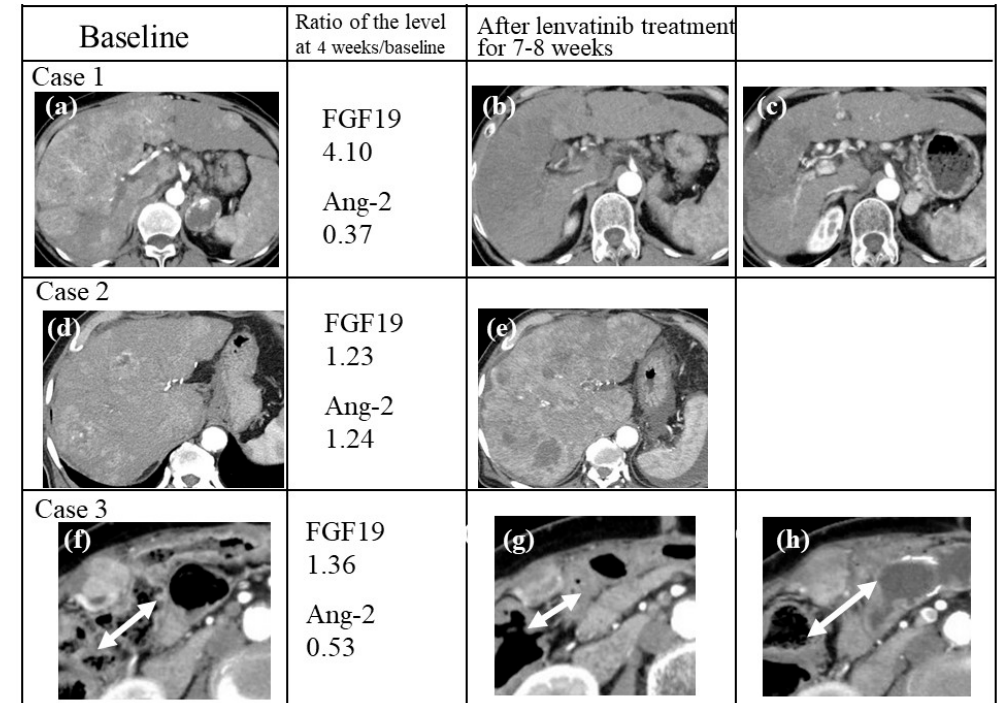
Figure 5. Representative liver lesions of HCC at baseline on arterial phase computed tomography (CT) ( a , d , f ) and CT scans of each patient after Lenvatinib treatment for 7 weeks ( e ) and 8 weeks ( b , g ), and at 67 weeks ( c ) and 37 weeks ( h ).